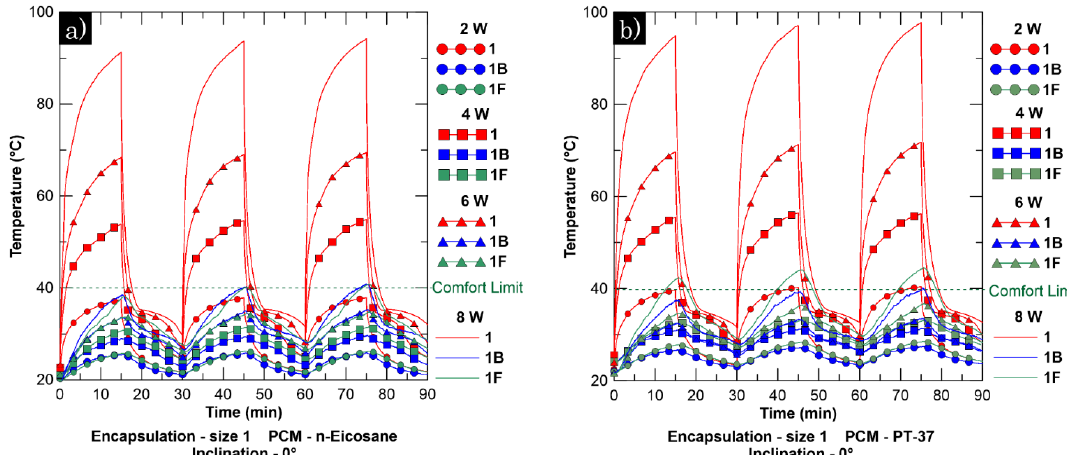
Figure 10. Influence of power input levels on the thermal response of the experimental tablet PC at 0° inclination with Size 1 PCM TES unit: ( a ) n- eicosane and ( b ) PT-37.